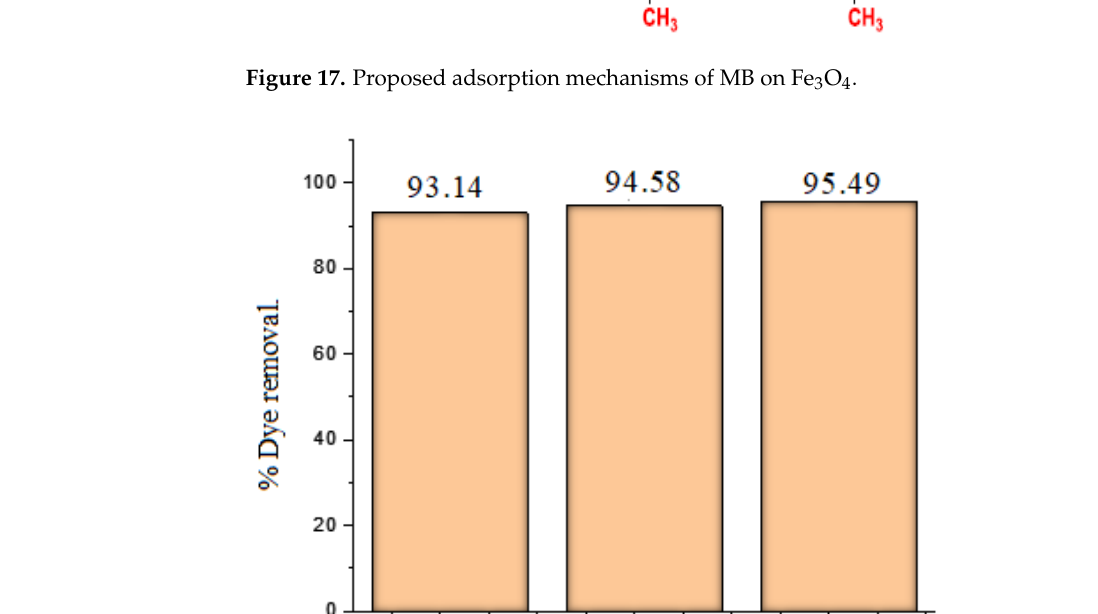
Figure 17. Proposed adsorption mechanisms of MB on Fe 3 O 4 .